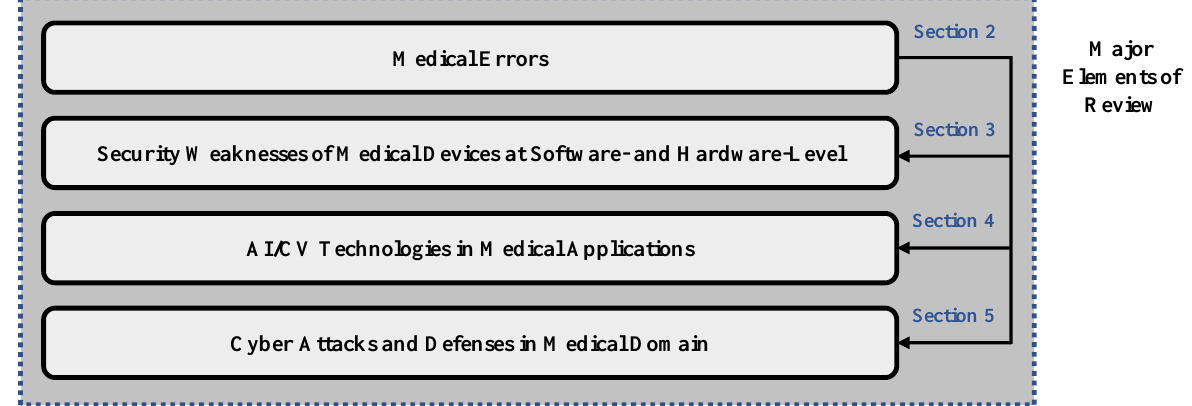
Figure 1. The four major contributing elements of this review on threats and vulnerabilities in medical domain.